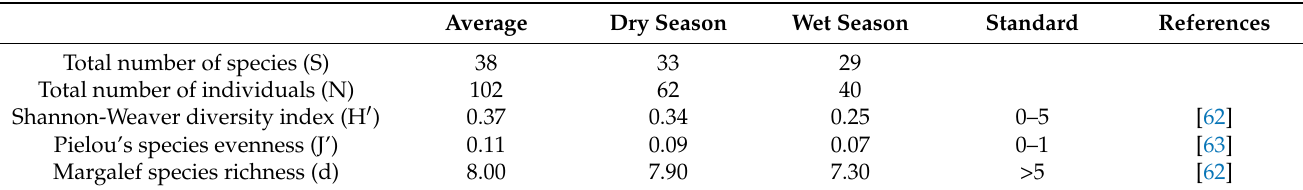
Table 5. Fish species diversity index values in the MRE during the dry and wet